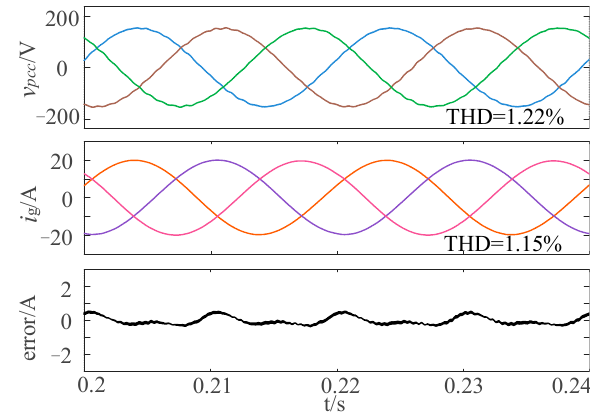
Figure 13. Steady ‐ state responses when Lg is 5 mH.